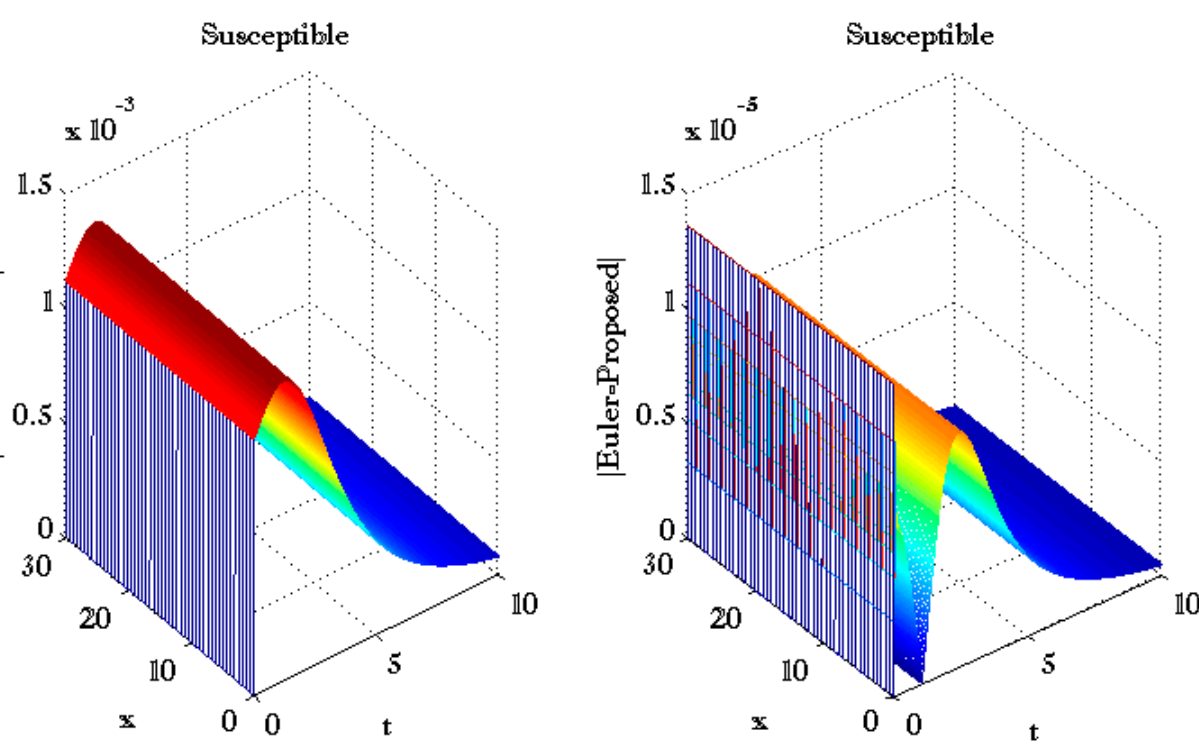
Figure 4. Three-dimensional comparisons of proposed and NSFD schemes for susceptible individuals using N x = 50, N t = 1300, α 1 = 0.1, β = 0.1, γ = 0.3, σ = 0.4, µ = 0.5, d 1 = 2, d 2 = 2.5, d 3 = 2.5, d 4 = 2, d 5 = 2, α = 0.9 .